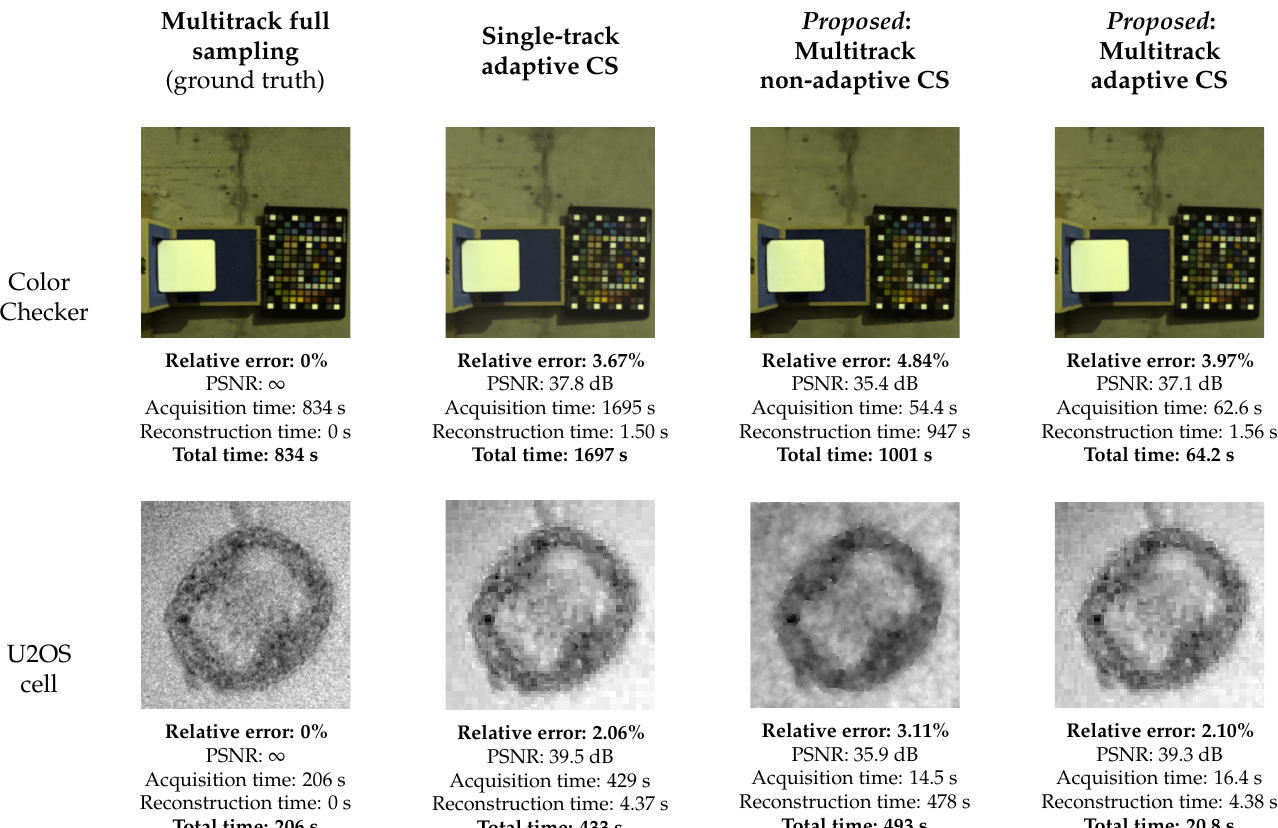
Figure 3. Simulations are carried out on the hyperspectral scenes Color Checker and U2OS cell. The reconstruction results are presented for each of the methods tested. For the Color Checker scene, pseudo-RGB versions of the reconstructed images are displayed in the table. For the U2OS cell scene, the 2964.5 cm − 1 band of the reconstructed image is